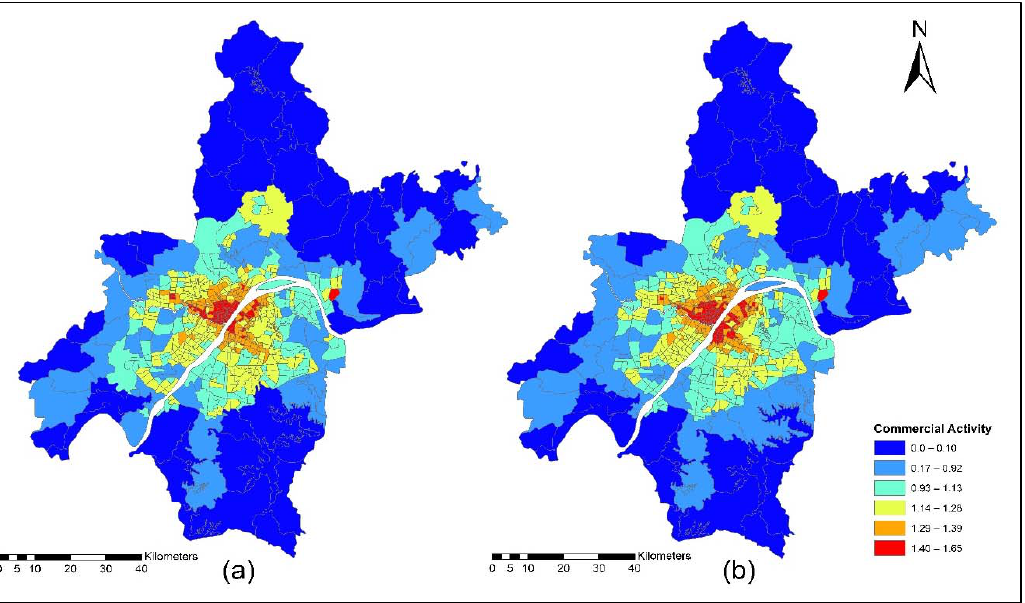
Figure 15. ( a , b ) Accessibility of commercial activities: ( a ) during morning peak for the year 2012; ( b ) during morning peak for the year 2015.